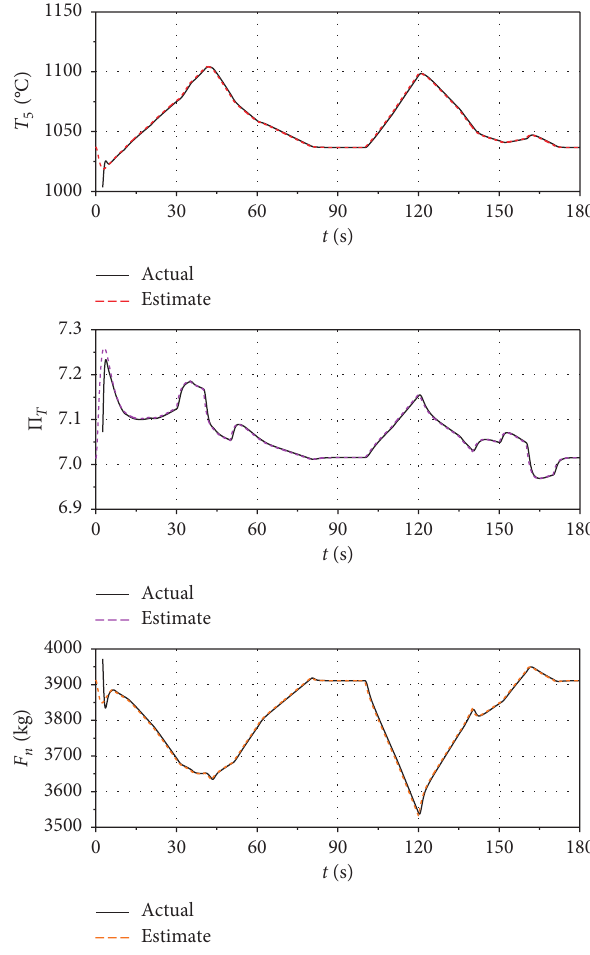
Figure 5: The estimation of performance parameter for Type I. Figure 6: The estimation of performance parameter for Type II. Table 2: Estimated errors of health and performance